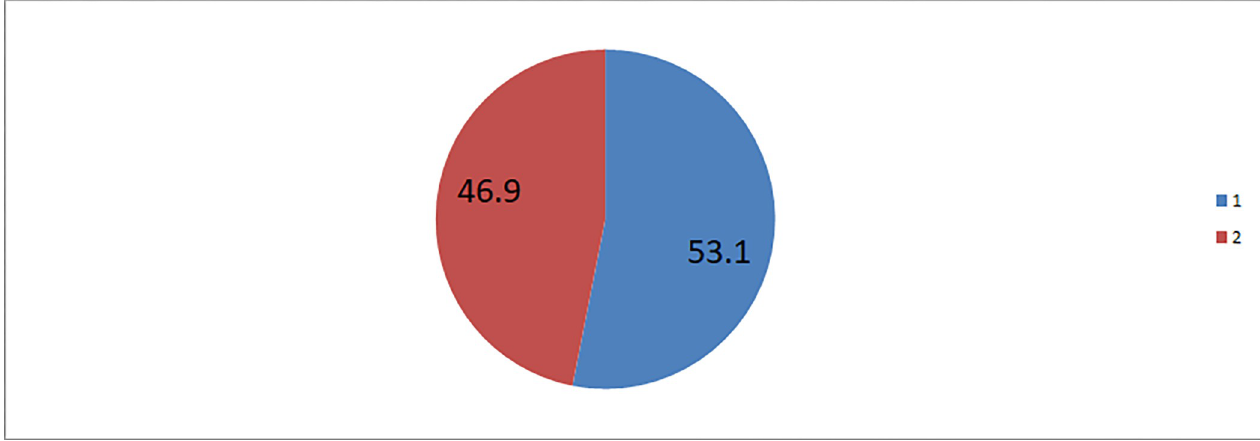
Fig 1. Knowledge on COVID-19 vaccination among pregnant women in Motta town and Hulet Eji Enese district northwest Ethiopia 2021. 1 = Inadequate knowledge on COVID-19 vaccination, 2 = Adequate knowledge on COVID-19 vaccination.